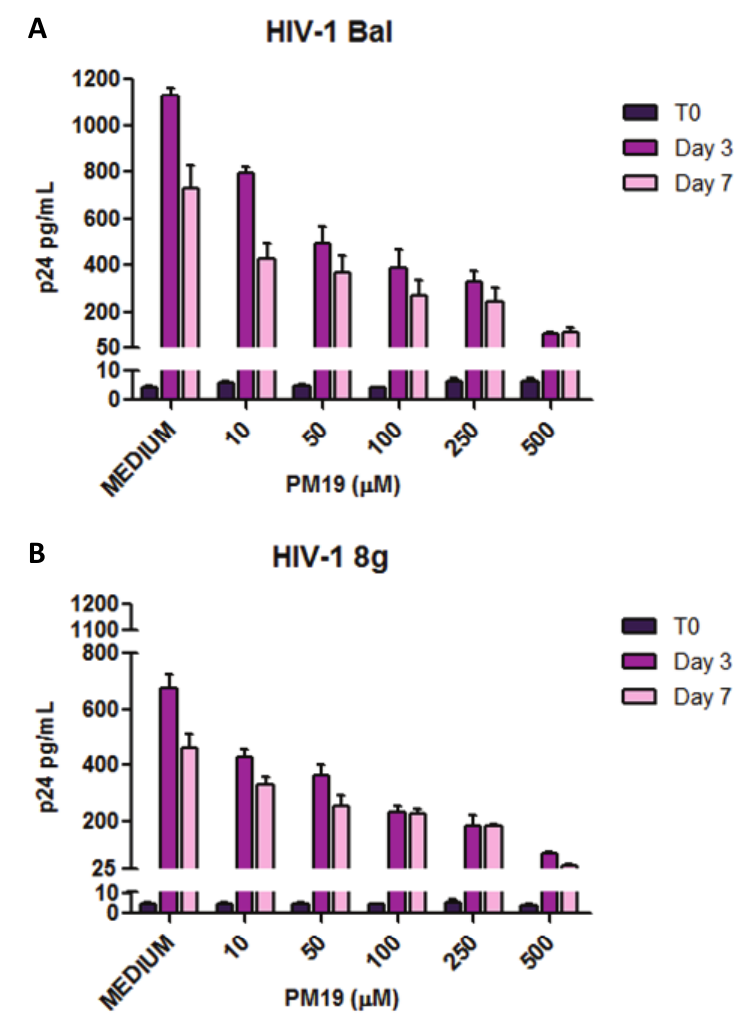
Figure 2. The compound PM 19 inhibits cervical explants infection by HIV-1 BaL ( A ) and primary isolate 8 g ( B ) in a dose-dependent manner. Experiments were performed on explants from 3 separate donors. Data represent the mean ±